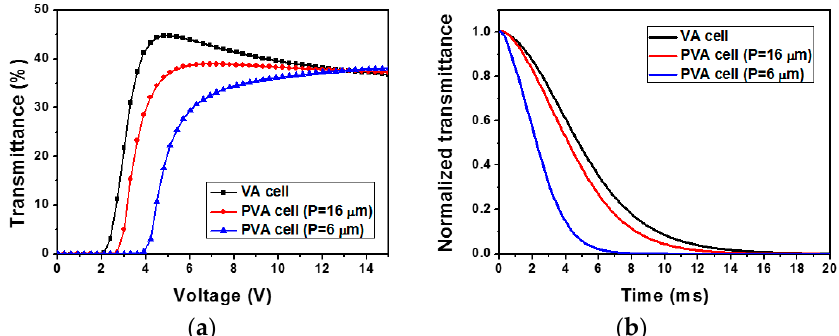
Figure 5. ( a ) Calculated voltage-transmittance curves and ( b ) temporal switching behavior during the turn-off process of PVA cells with the pitch P of patterned electrodes as a parameter. The spacing L between patterned electrodes was fixed at 2 μ m.